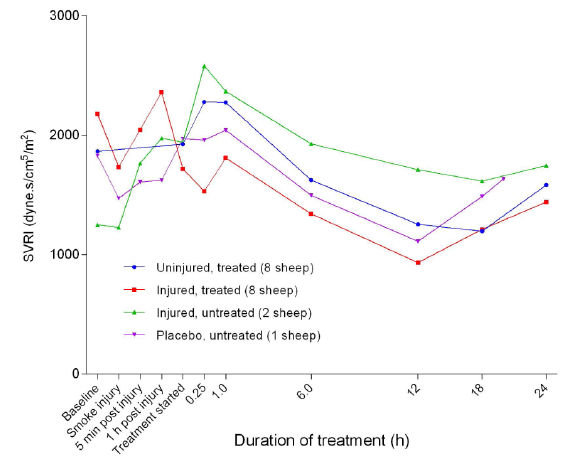
Figure 29. Stroke volume index (SVI) (Mean ± SD, error bars not shown) in smoke and non-smoke injured sheep that received extracorporeal life support as compared to that in untreated controls.